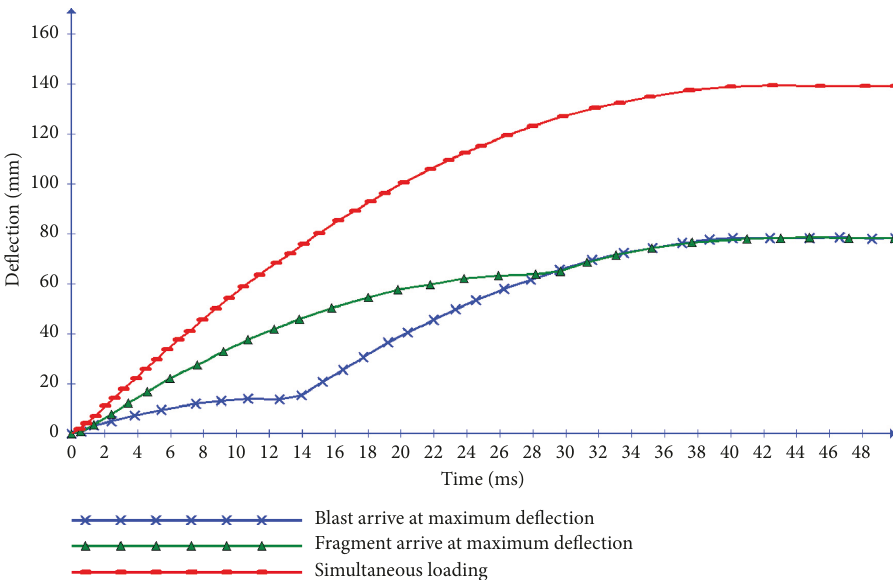
Figure 11: SDOF-based displacement-time history plot for different loading cases [3].